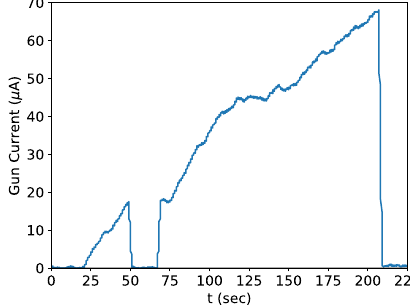
FIG. 7. Plot of average beam current in gun during higher current